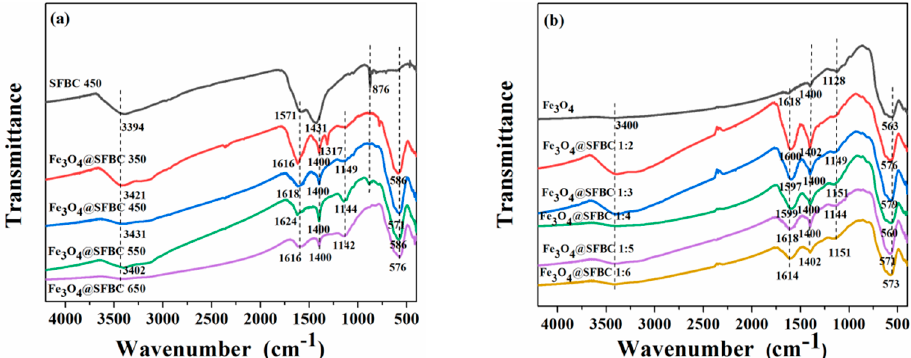
Figure 2. FTIR spectra of Fe 3 O 4 nanomaterials prepared using biochar at different calcination temperatures ( a ) and FTIR spectra of Fe 3 O 4 nanomaterials prepared by different SFBC/Fe mass ratios ( b ).